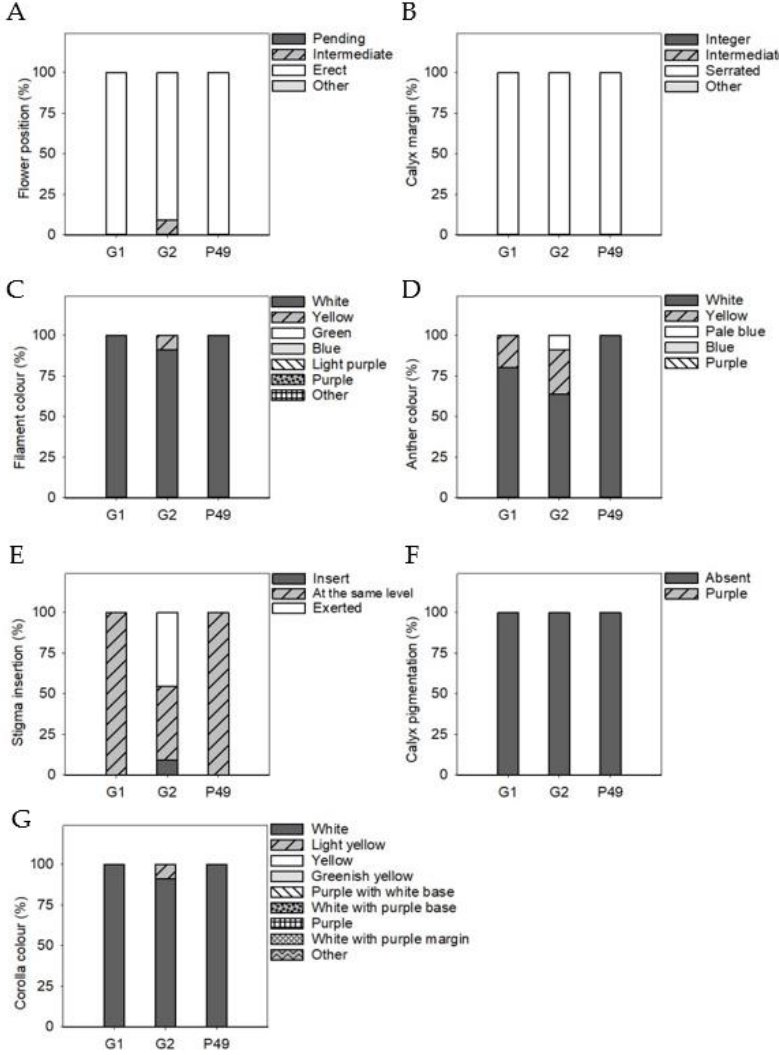
Figure 3. Frequency distribution of the flower qualitative traits in the 17 pepper landraces. ( A ) Flower position; ( B ) Calyx margin; ( C ) Filament colour; ( D ) Anther colour; ( E ) Stigma insertion; ( F ) Calyx pigmentation; ( G ) Corolla colour. The mean value for each landrace was represented by the most frequent representation of the trait after classifying the independent plant samples ( n = 8) according to the scale (Table S1).